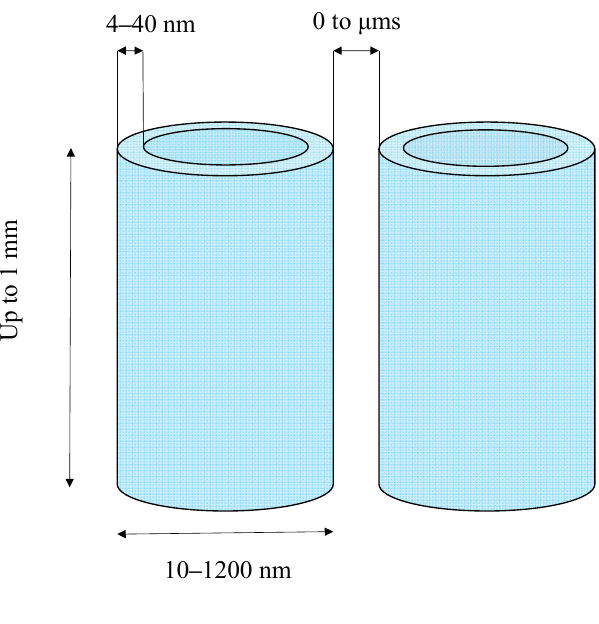
Figure 1. Scheme indicating the ranges of the most often reported dimensions of